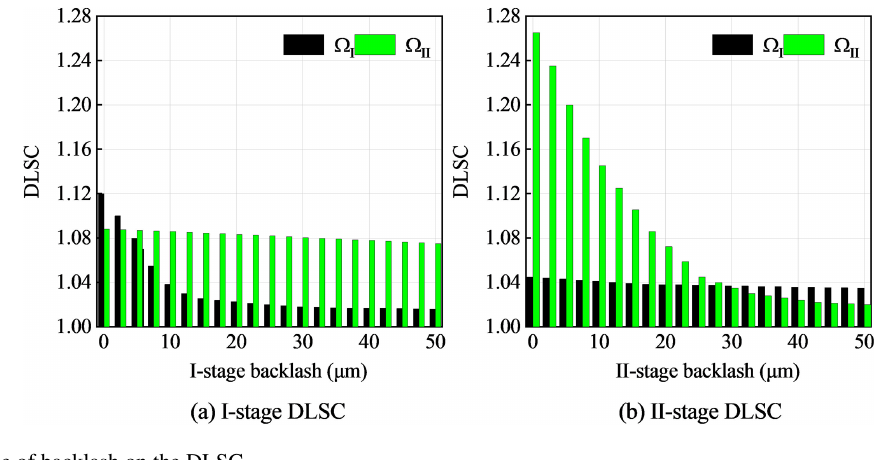
Figure 13. Influence of backlash on the DLSC.